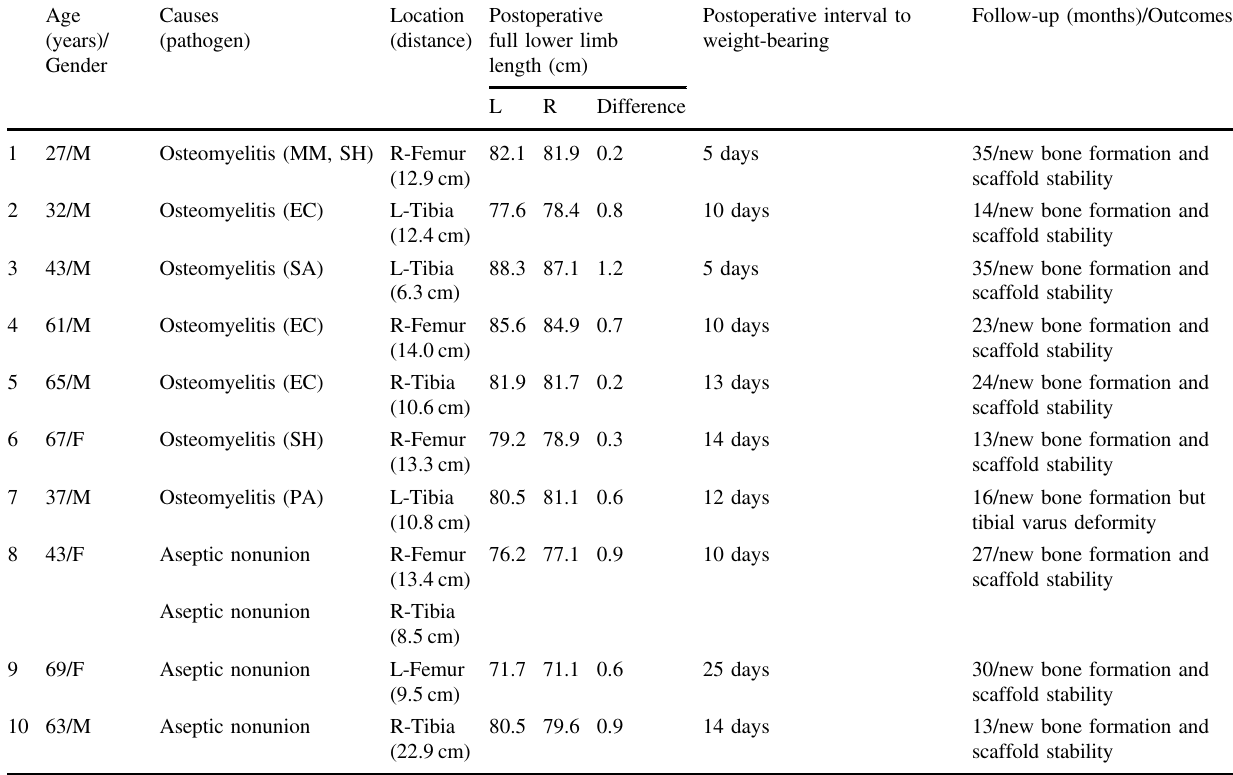
Table 1 Clinical characteristics of typical patients from our